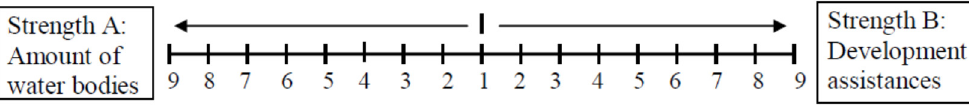
Figure 1. A sample questionnaire of a pair wise comparison between strength factors. Respondents were requested to compare the importance of the two factors and based on his preferences of the particular factor he was asked to assign a weight from 1 to 9 for the relatively important factor to reflect the magnitude of the importance. The same process was followed for all pair wise comparisons.